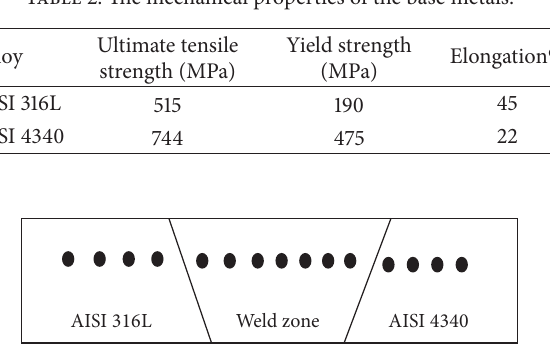
Table 2: The mechanical properties of the base metals.